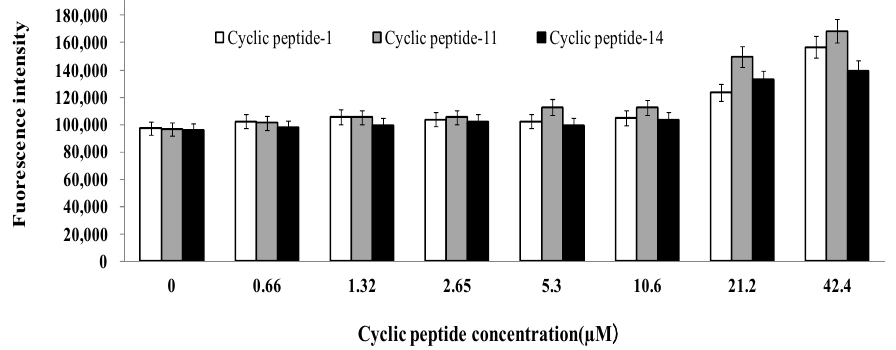
Figure 8. Influence of cyclic peptides on membrane and cellular integrity.